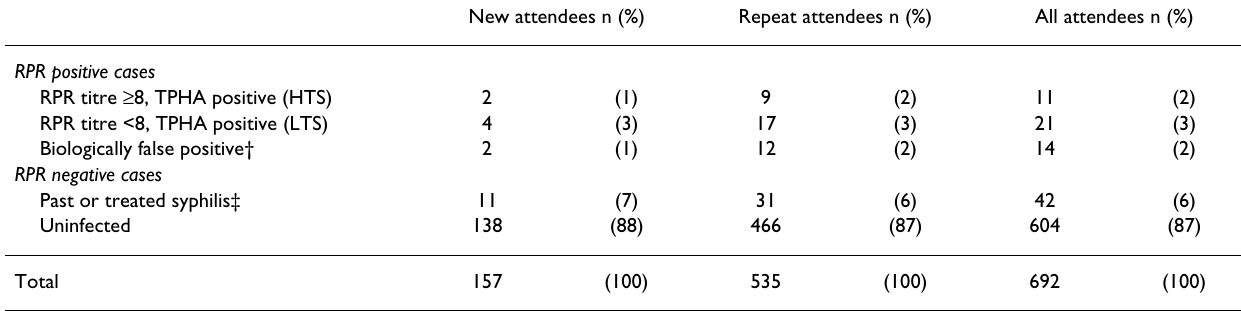
Table 2: Syphilis prevalence among 692* antenatal care attendees in Gaborone, Botswana New attendees n (%) Repeat attendees n (%) All attendees n (%) RPR positive cases